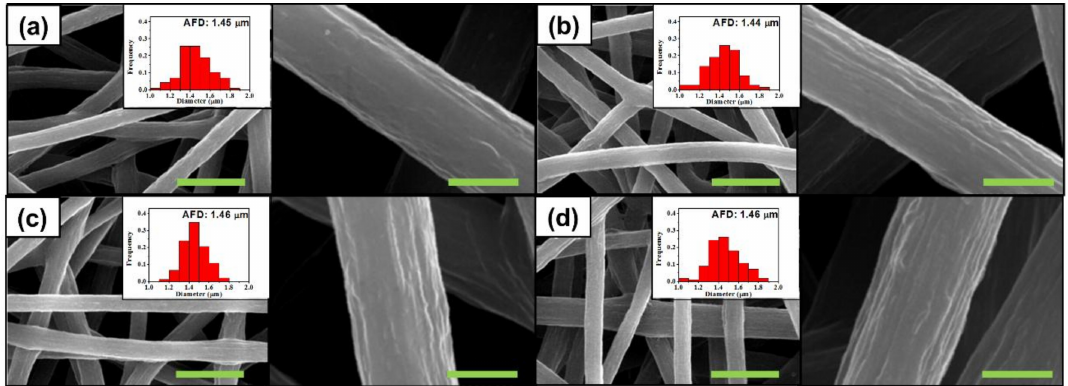
Figure 2. SEM images and diameter distributions of electrospun PEI/PVdF (1:1 wt. ratio) fibers collected after the interval of ( a ) 10 min; ( b ) 20 min; ( c ) 30 min; and ( d ) 40 min. Right images are enlarged for morphology observation. The green scale bars are 6 µ m and 1 µ m, accordingly. The frequencies in insets were normalized by the number of counted samples. AFD is the abbreviation for average fiber